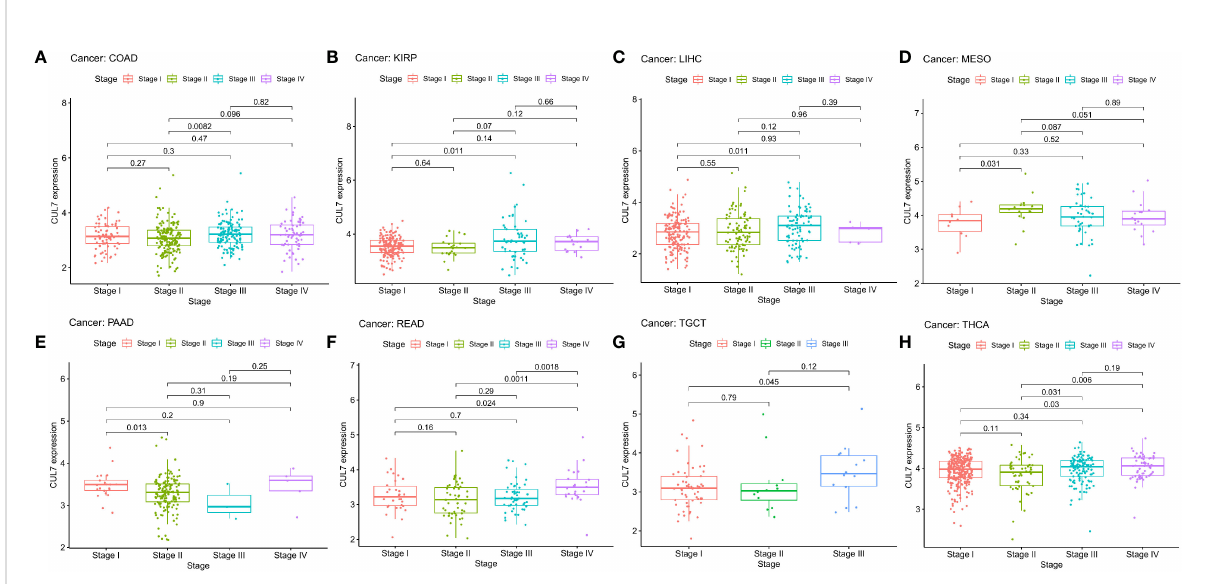
FIGURE 3 Correlation between CUL expression and tumor pathological grades (Stage I, II, III, IV). (A) COAD, (B) KIRP, (C) LIHC, (D) MESO, (E) PAAD, (F) READ, (G) TGCT, (H)